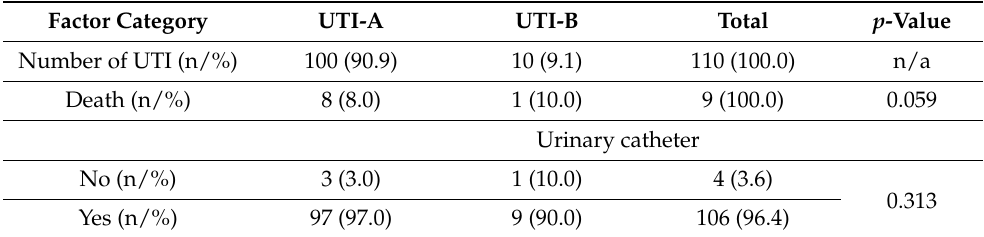
Table 4. Analysis of UTI considering the presence of a catheter, mortality in ICU in 2016–2019.